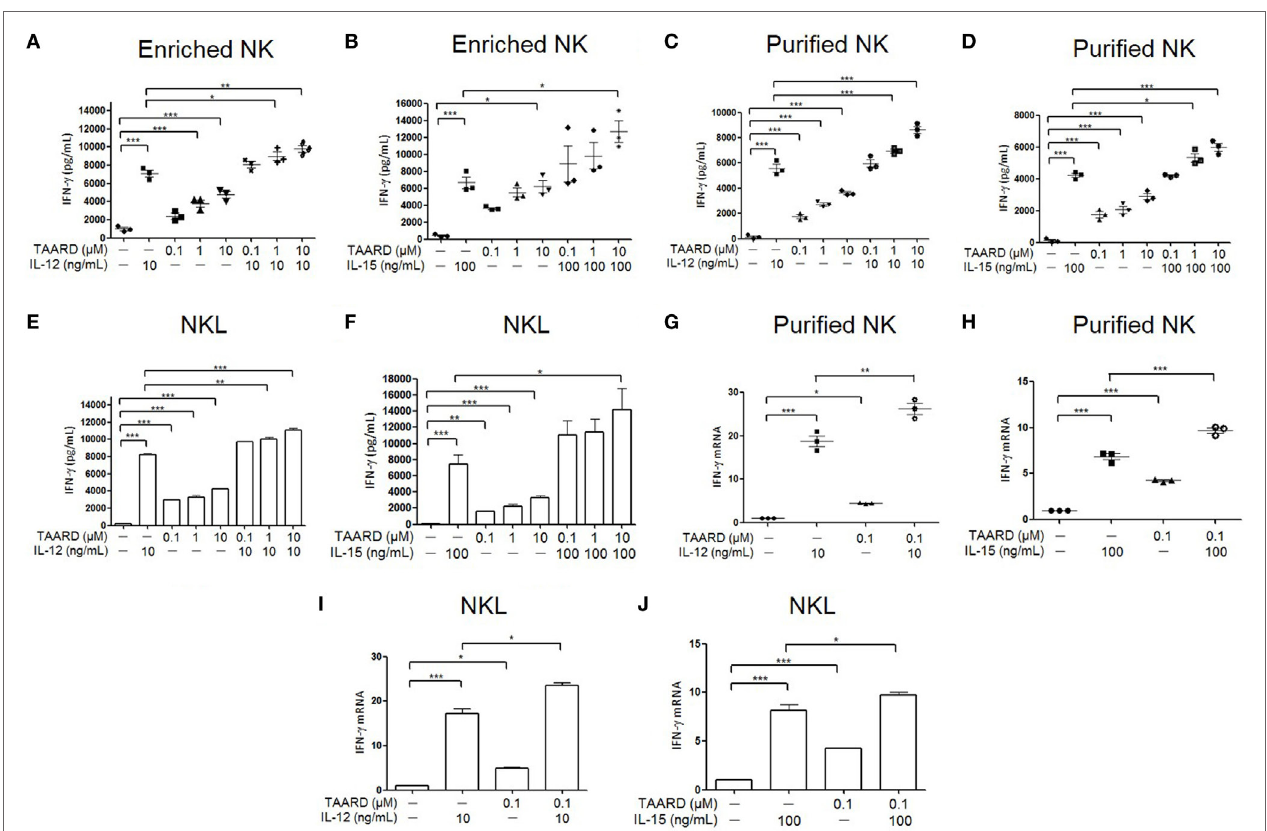
FigUre 1 | TAARD stimulates interferon (IFN)- γ production in natural killer (NK) cells. (a,B) Enriched human NK cells were treated with DMSO vehicle control or different concentrations (0.1, 1, and 10 µM) of TAARD for 18 h in the presence or absence of IL-12 (10 ng/mL) (a) or IL-15 (100 ng/mL) (B) . Cell-free supernatants were collected and analyzed by enzyme-linked immunosorbent assay (ELISA) to determine IFN- γ release in enriched human NK cells ( n = 3 in each treatment). (c,D) Highly purified ( > 98%) human NK cells were treated with DMSO vehicle control or different concentrations (0.1, 1, and 10 µM) of TAARD for 18 h in the presence or absence of IL-12 (10 ng/mL) (c) or IL-15 (100 ng/mL) (D) to determine the level of IFN- γ release by ELISA. (e,F) NKL cells were treated with DMSO vehicle control or various concentrations (0.1, 1, and 10 µM) of TAARD for 18 h in the presence or absence of IL-12 (10 ng/mL) (e) or IL-15 (100 ng/mL) (F) . Cell-free supernatants were collected and analyzed by ELISA to determine IFN- γ release in enriched NK cells. (g,h) Highly purified NK cells were treated with DMSO vehicle control or 0.1 µM of TAARD for 18 h in the presence or absence of IL-12 (10 ng/mL) (g) or IL-15 (100 ng/mL) (h) . IFNG mRNA expression was assessed by real-time RT-PCR and relative IFNG mRNA expression for each treatment group was normalized to the untreated vehicle control in the same donor. (i,J) NKL cells were treated with DMSO vehicle control or 0.1 µM of TAARD for 18 h in the presence or absence of IL-12 (10 ng/mL) (i) or IL-15 (100 ng/mL) (J) . IFNG mRNA expression was assessed by real-time RT-PCR and relative IFNG mRNA expression of each treatment group was normalized to the untreated vehicle control. The data are presented as mean ± SEM ( n = 3 for each treatment; error bars represent the SEM for primary NK cells). Data shown as mean ± SD for NKL cells, which represent at least three independent experiments. * p < 0.05, ** p < 0.01, and *** p < 0.001 denote statistical comparison between the two marked treatment